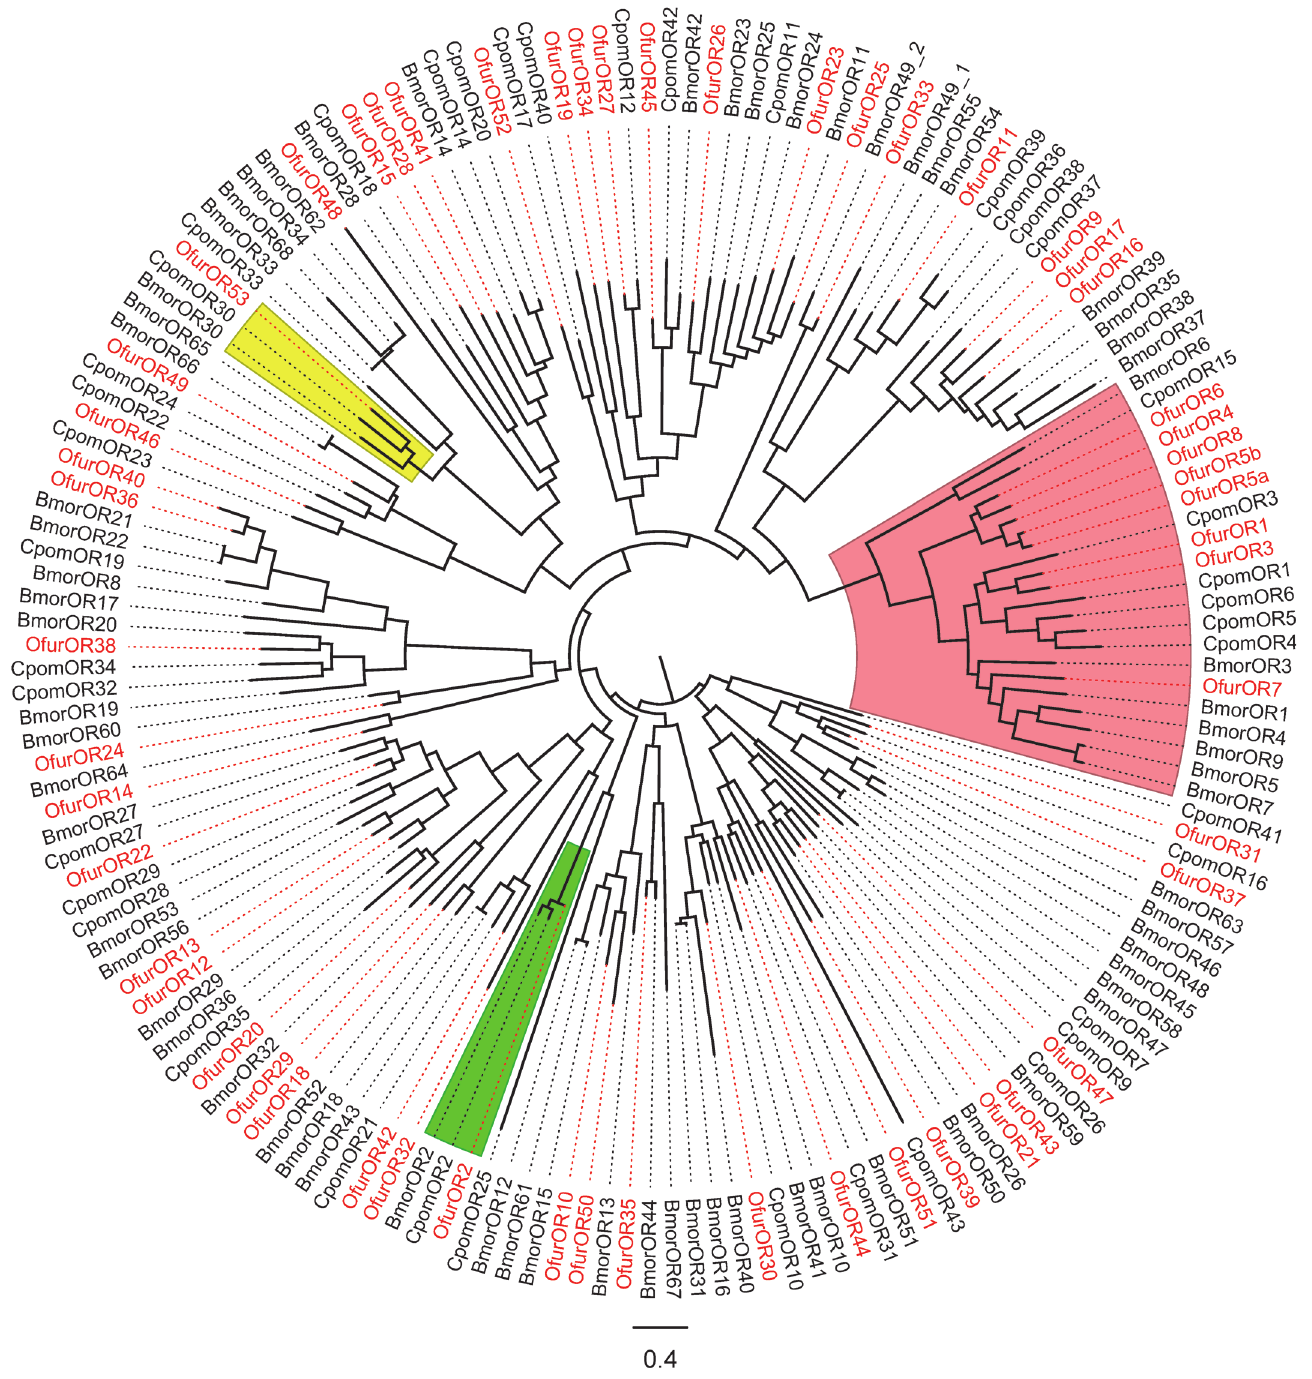
Fig 3. Phylogenetic relationship of O. furnacalis odorant receptors ( OfurORs ) with those of B. mori ( BmorORs ) and C. pomonella ( CpomORs ). The tree was constructed by the maximum likelihood method using RAxML and visualized using FigTree. OfurORs are indicated in red. Green, pink, and yellow shading indicates the clades of Orco , pheromone receptors, and OfurOR53 , respectively.